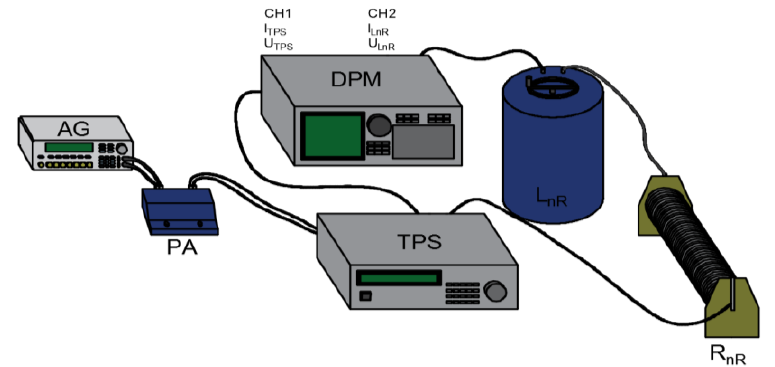
Figure 5. The measuring circuit used to determine the maximum rms values of the output current and voltage of the tested power sources for a sinusoidal input voltage of frequency 50 Hz.